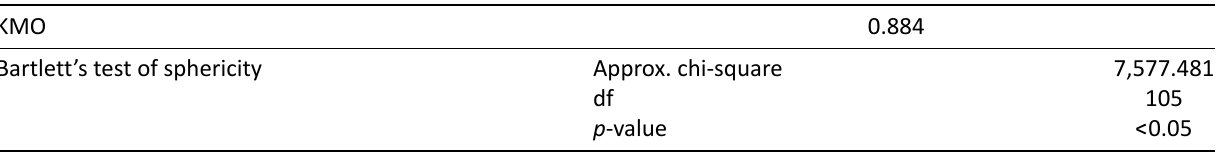
Table 2. KMO and Bartlett’s